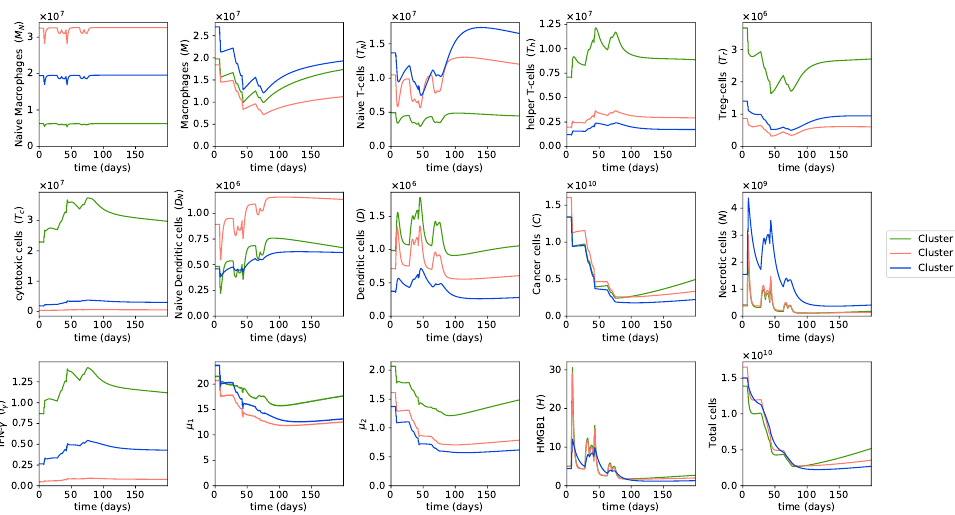
Figure 3. Dynamics with MAP treatment. Behaviors of cells and cytokines in osteosarcoma tumors during the MAP treatment and a few months after treatment. Initial conditions are large tumors in each cluster, i.e., the without-treatment steady state values of each cluster. Drug doses are the typical doses of the MAP regimen. The different color lines indicate the dynamics of different